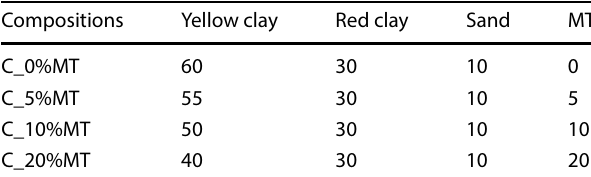
Fig. 5 Sand grain size distribution